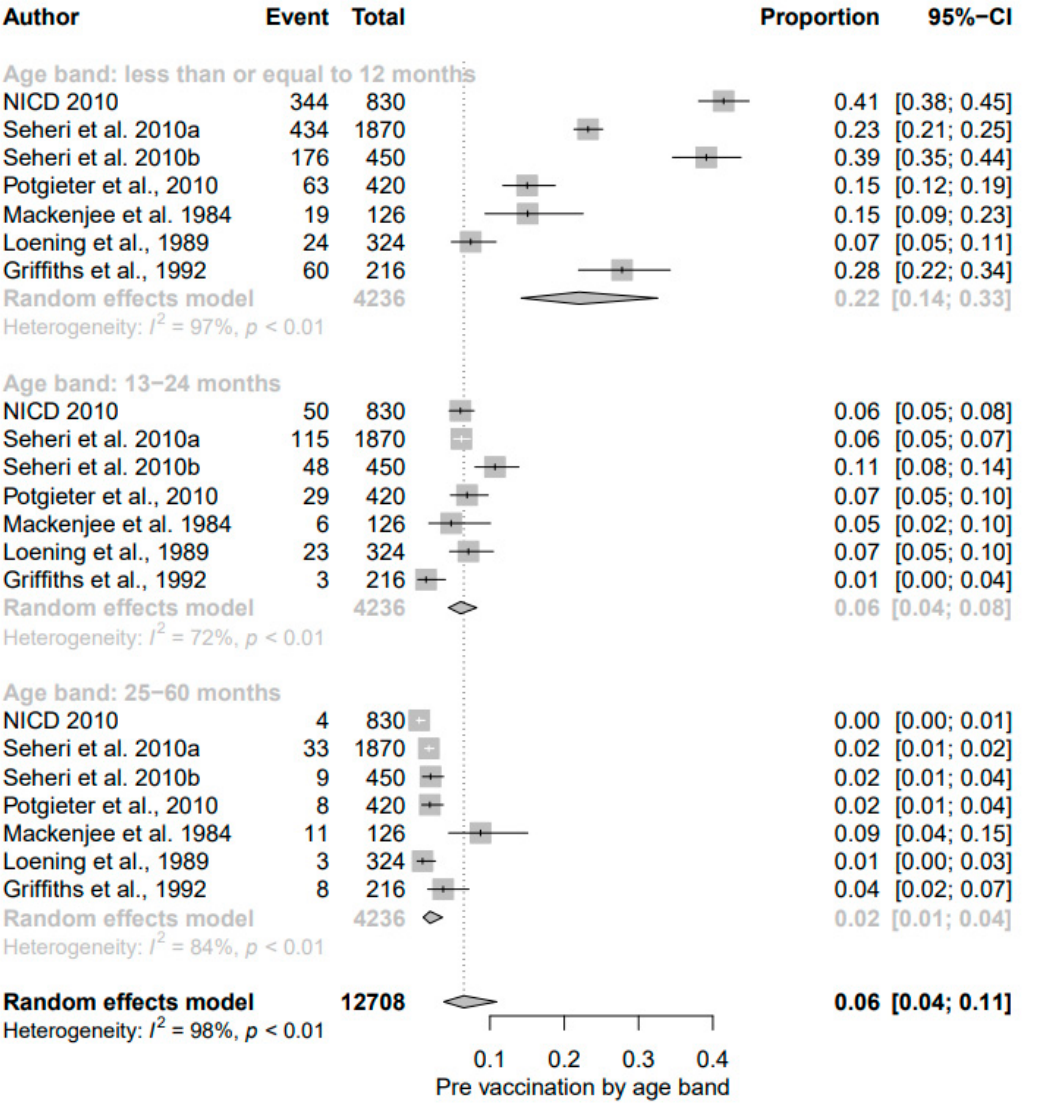
Figure 6. Subgroup analysis of rotavirus prevalence during pre-vaccination era according to age group. The subgroup analysis by study period was conducted to assess the potential hetero- geneity between studies carried out during the post-vaccination era. Of the 20 studies, the highest estimated prevalence was found in studies conducted in 2013 (12 months) (29% (95% CI: 25%, 34%), I 2 = 65%) followed by studies conducted in 2011 (12 months) (25% (95% CI: 20% to 31%), I 2 = 86%) while the lowest estimated prevalence was found in studies conducted in 2012 (12 months) (19% (95% CI: 17%, 22%)) (Supplementary Figure S3). The result of subgroup analysis in relation to age groups showed a significant reduc- tion in prevalence of diarrheal cases due to rotavirus among children aged ≤ 12 months following vaccine introduction; the detection rate (22% (95% CI: 14%, 33%); I 2 = 97%) in the pre-vaccine era declined to 16% ((95% CI: 13%, 18%); I 2 = 88%, p < 0.01) in the post-vaccine era (Figures 6 and 7). While the overall prevalence remained unchanged between the two different periods for those aged 13–24 months, a decline of 1% was observed among older children in the post-vaccine